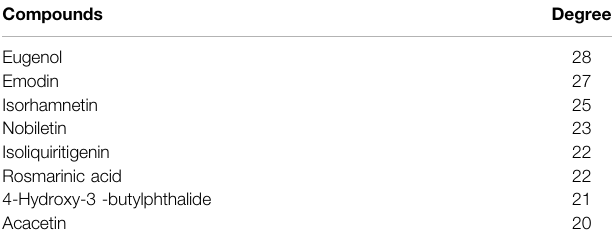
TABLE 3 | The topological parameters of 20 main active components. Compounds